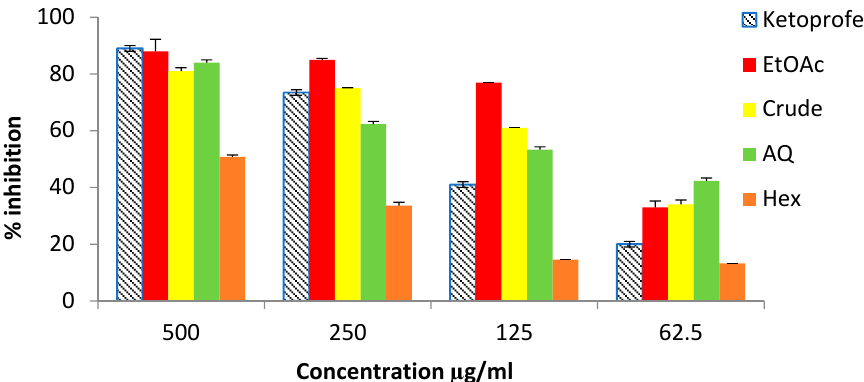
Figure 2. Inhibitory ability of S. vulgare crude extract and of purified fractions towards albumin denaturation. Crude—crude extract; Hex—hexane fraction; EtOAc—ethyl acetate fraction; AQ—aqueous residue.